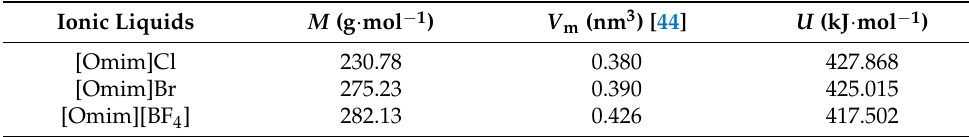
Table 2. The lattice energy of ionic liquids.